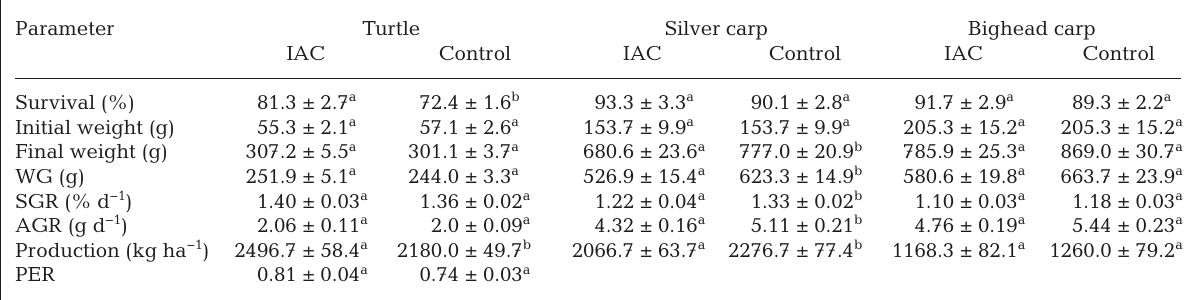
Table 1. Growth performance of Chinese soft-shelled turtle Pelodiscus sinensis and 2 carp species (silver carp Hypoph- thalmichthys molitrix and bighead carp Aristichthys nobilis) cultured for 4 mo under 2 different treatments in aquaculture ponds. Data are means ± SD of 3 replicate ponds. For each row, means with different superscript letters are significantly different from each other (p < 0.05). IAC: Ipomoea aquatica treatment; WG: weight gain; SGR: specific growth rate;